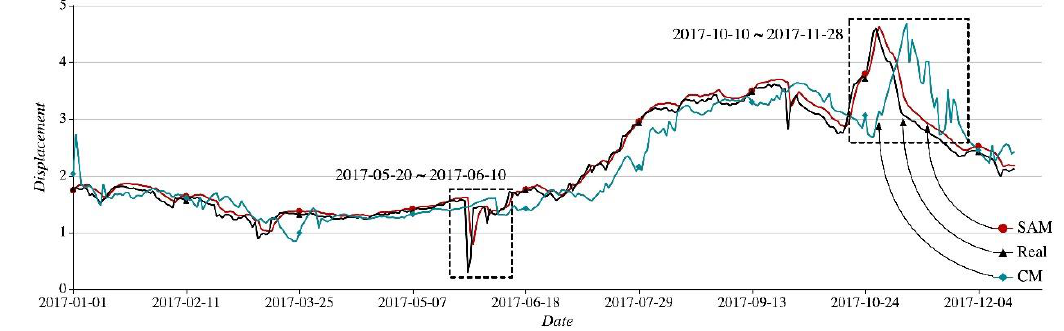
Figure 10. Prediction Results from 1 January 2017 to 31 December 2017. Taking the two periods of time marked with the dotted box, that is, 28 May 2017–4 June 2017 and 10 October 2017–28 November 2017 we find that the SAM, CM, and Real curves are divergent from each other greatly. The details can be seen in Figure 11a,b.